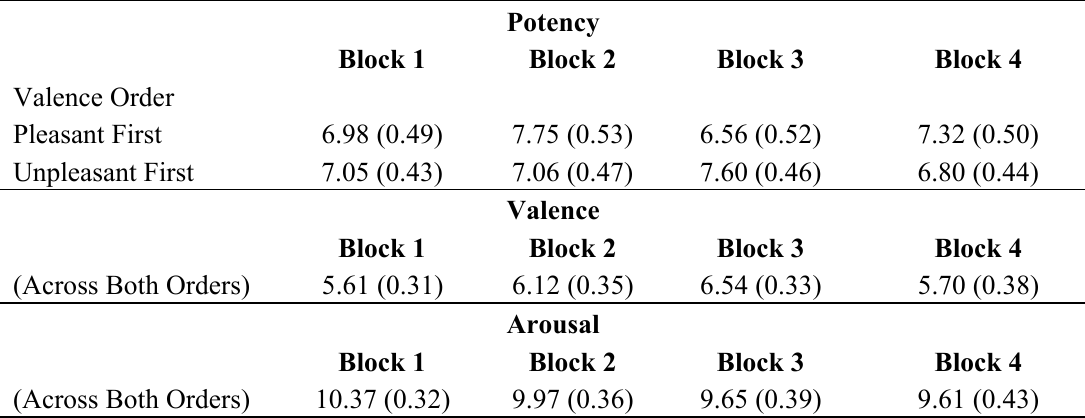
Table 2. Visual Analog Scale mood means in centimeters for potency, valence, and arousal scales for all four stimulus